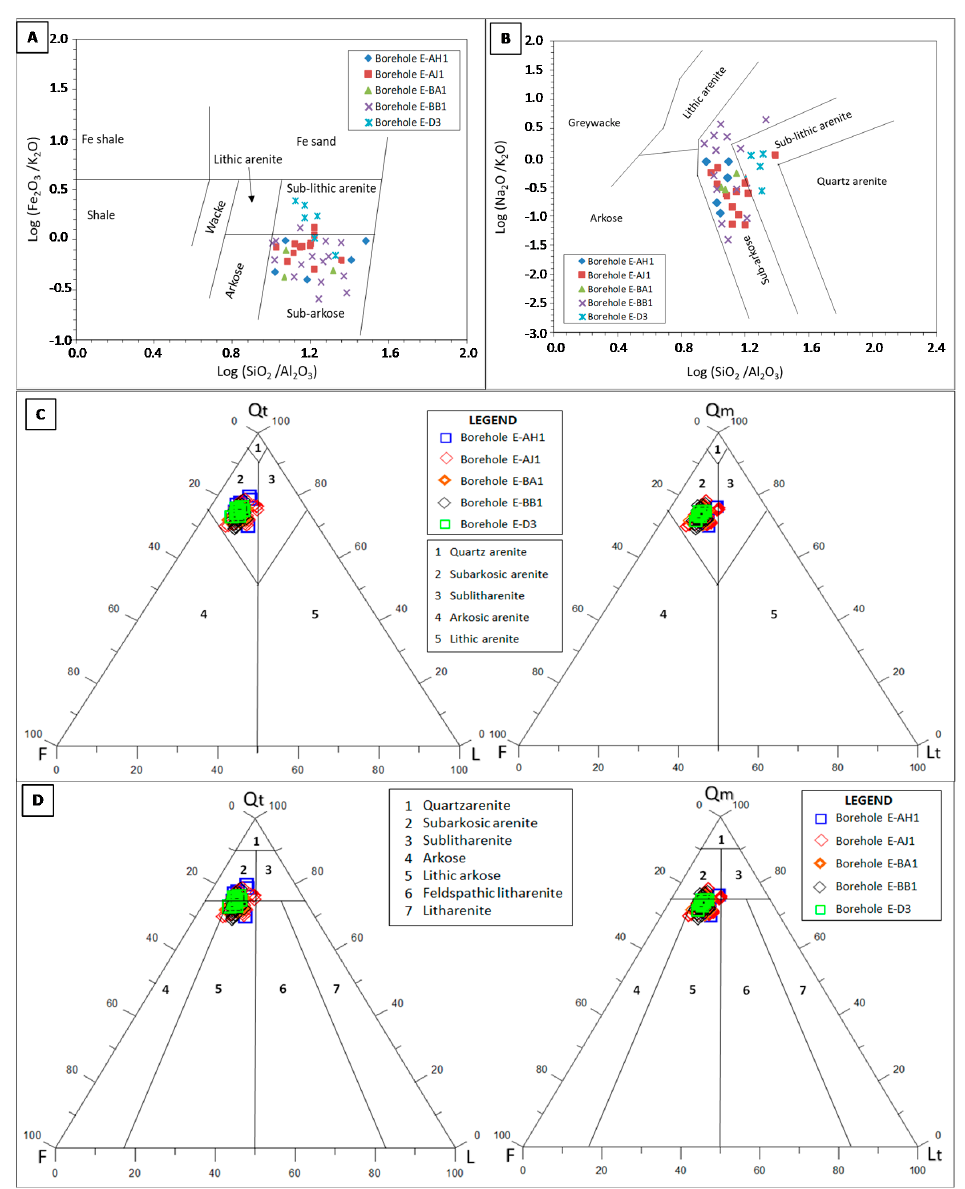
Figure 8. Classification of the Bredasdorp sandstones based on: ( A ) Binary plot of Log (Na 2 O/K 2 O) versus Log (SiO 2 /Al 2 O 3 ) (after [51]); ( B ) Binary plot of Log (Fe 2 O 3 /K 2 O) versus Log (SiO 2 /Al 2 O 3 ) (after [52]); ( C ) Ternary plot of total quartz-feldspar-lithic fragments (Qt-F-L) and monocrystalline quartz-feldspar-total lithic fragments (Qm-F-Lt) (after [47]); ( D ) Ternary plot of total quartz-feldspar-lithic fragments (Qt-F-L) and monocrystalline quartz-feldspar-total lithic fragments (Qm-F-Lt) (after [50]).